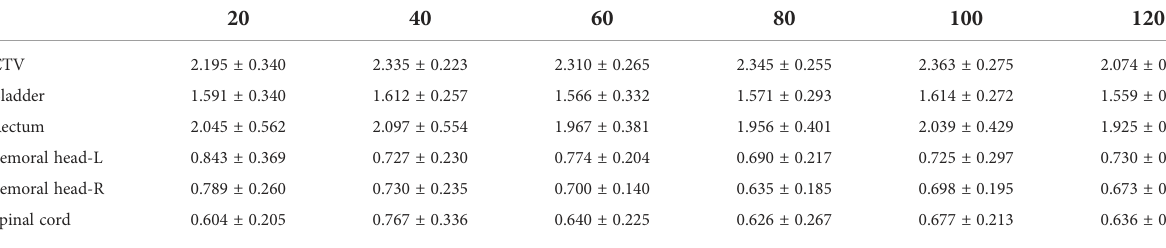
TABLE 4 The HD value of CTV and OARs in different atlas library groups (mean ± SD, cm).